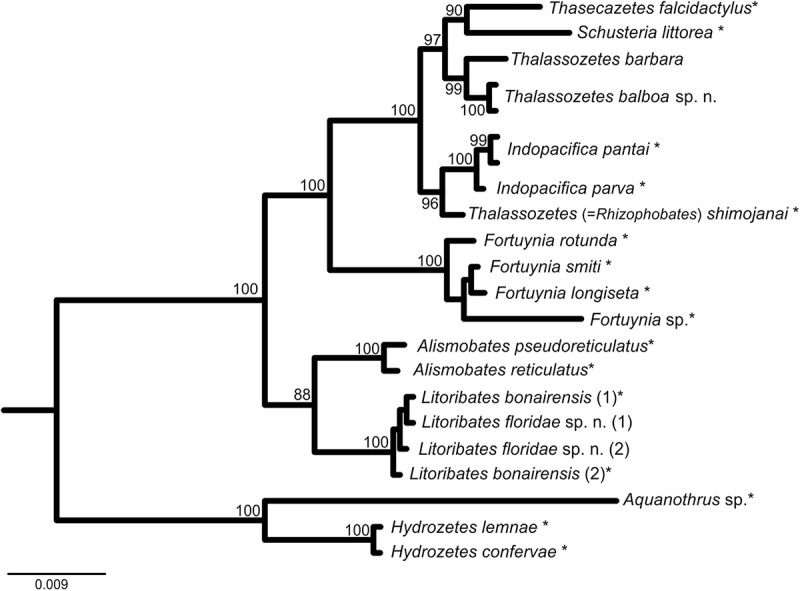
Bayesian inference tree of fortuyniid and selenoribatid taxa based on 18S rRNA sequences (1811 bp) constructed by means of MrBayes applying the GTR+I+G model. Posterior probabilities (>80) are shown near nodes. Sequences obtained from GenBank are marked by *. For details, see Table 1.